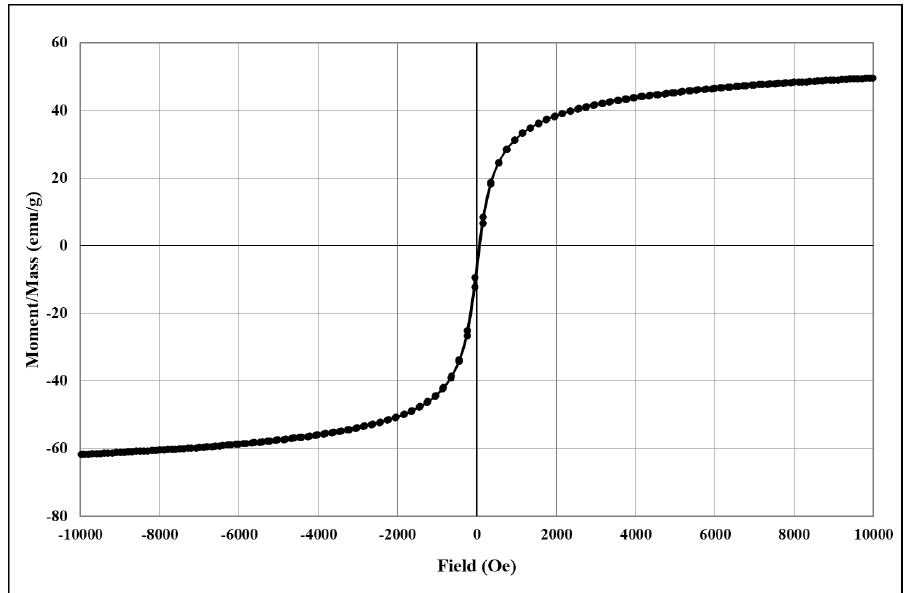
Figure 5. The magnetization/mass ratio for Fe 3 O 4 @citrate@1a.